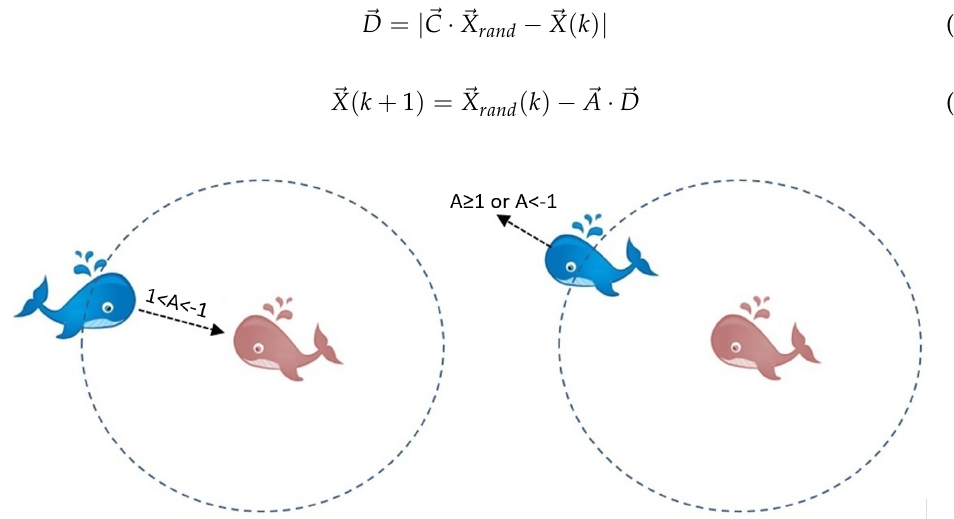
Figure 7. Updating whale position either towards or moving away from a randomly picked hump- back